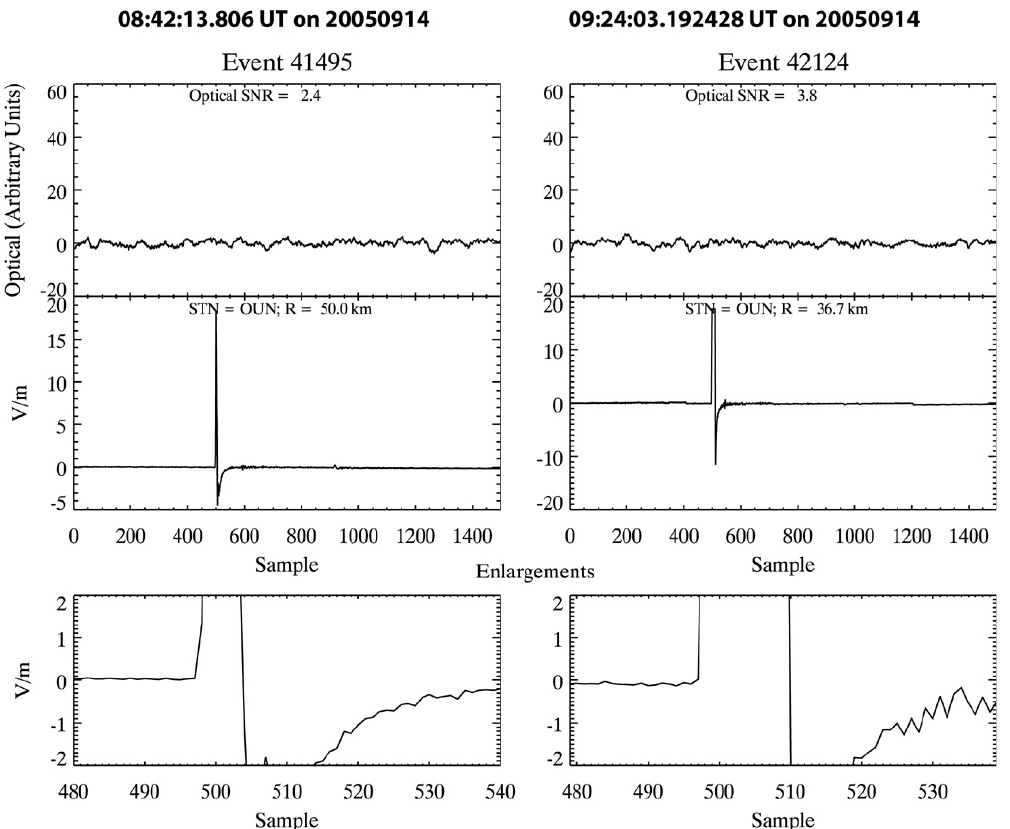
Fig. 17. Two + NB events of similar sferic intensity to those shown in Fig. 16, but which do not show optical emission. The panels are laid out as in Fig. 16 for direct comparison. Note that for both events we show the sferic data from the closest station (in Oklahoma City) to the optical sensor. The reason is that we wish to highlight any possible additional radio disturbances prior to the main NB pulse. However, we still find a complete absence of additional radio disturbances. The bottom panel close-up shows that these events rise more rapidly from background levels to their peaks (rise-time < 5µs), in contrast to the events shown in Fig.